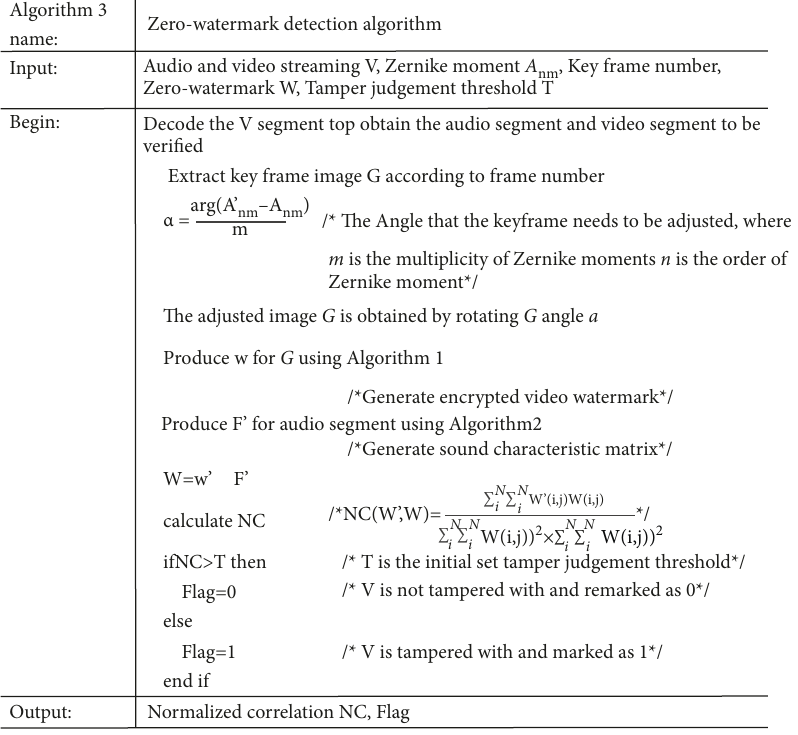
Figure 7: Audio and video matching detection algorithm